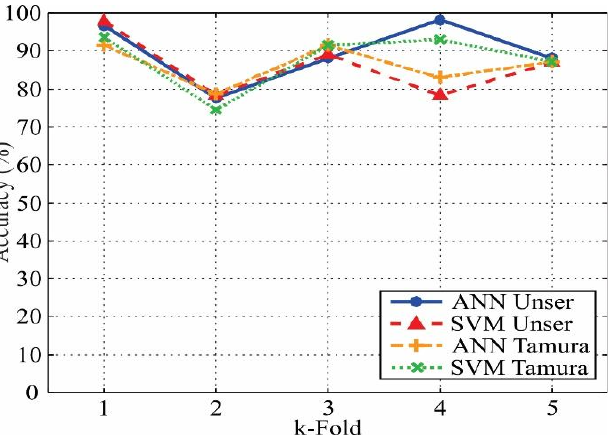
Figure 9. Accuracy results for the ANN and SVM methods during the k-fold validation. Table 3. Accuracy percentage mean ( μ ) for the ANN and SVM classifiers by considering different contrast estimation methods.